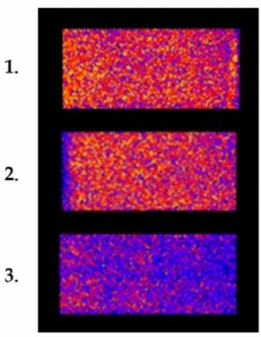
Figure 7. Magnetic resonance imaging (MRI) of Core A: ( 1 ) Saturated kerosene state; ( 2 ) after displacing 1 pore volume (PV); ( 3 ) after displacing 10